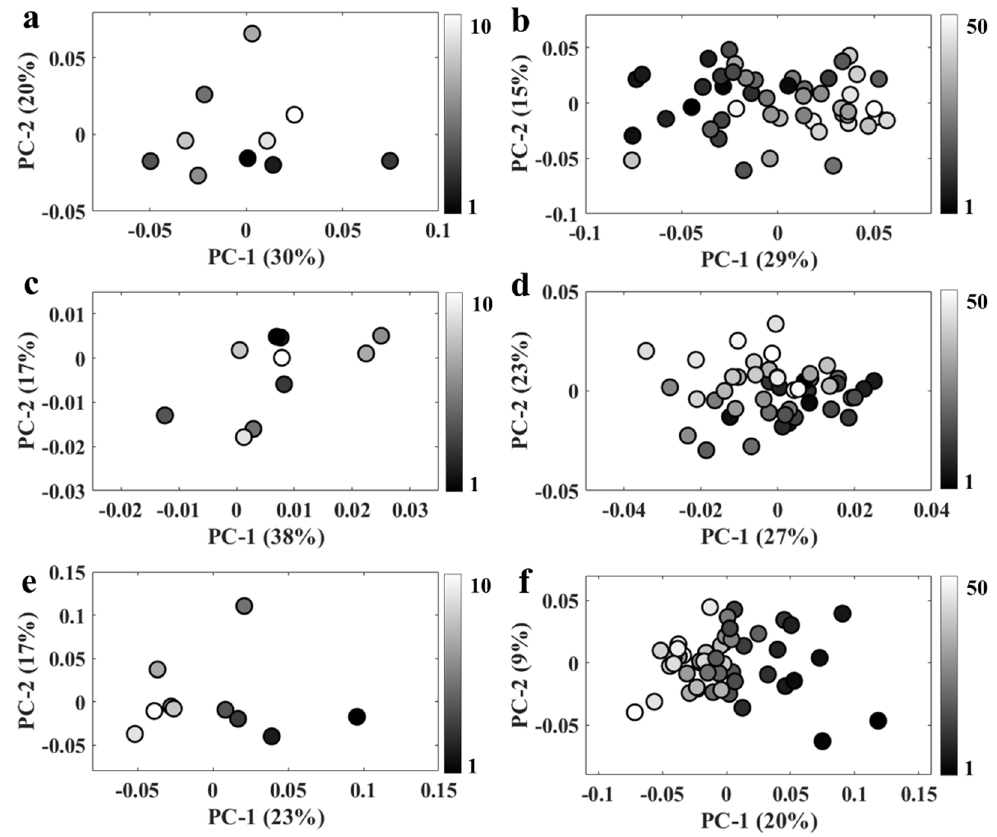
Figure 3. PC scores plot obtained from spectra acquired from the same spot. ( a , b ) 10 and 50 infrared spectra from a single bacterium; ( c , d ) 10 and 50 infrared spectra obtained from bulk; ( e , f ) 10 and 50 Raman spectra collected from bulk populations. The grey-scale color of the symbols relates to the number of repeat spectral acquisitions from the same spots.